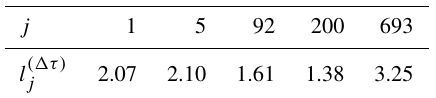
(b) Element D 92 , 92 of the diffusion matrix. Table 6. Correlation length l ((cid:49)τ) of the time series of the FTLE j (cid:51) ((cid:49)τ)